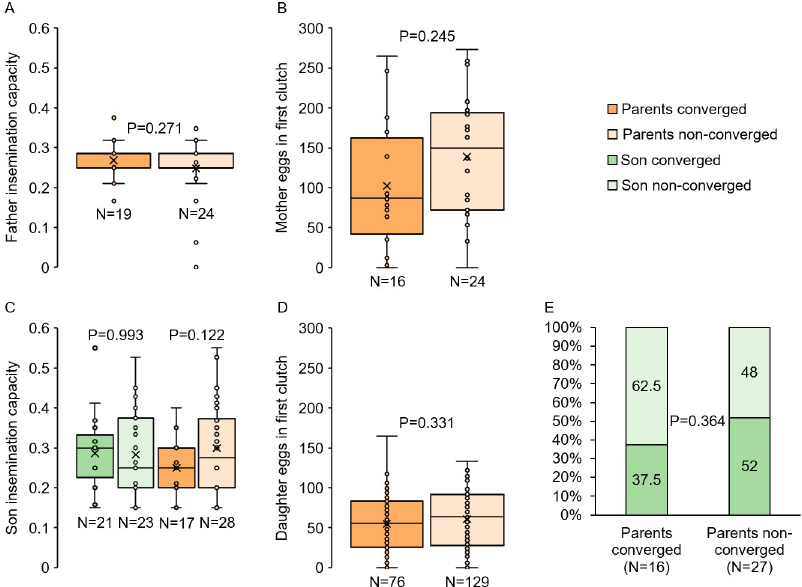
Fig 2. Harmonic convergence signals neither parent nor offspring reproductive fitness traits. Neither father fertility (A), mother fecundity (B), son fertility (C), nor daughter fecundity (D) differed by either parent or offspring harmonic convergence status (P � 0.122 for all comparisons). Son convergence status did not differ between those descending from converged parents and those descending from non-converged parents (E). Graphs display sample sizes (N) and LM, LMM, or GZLMM P-values for each